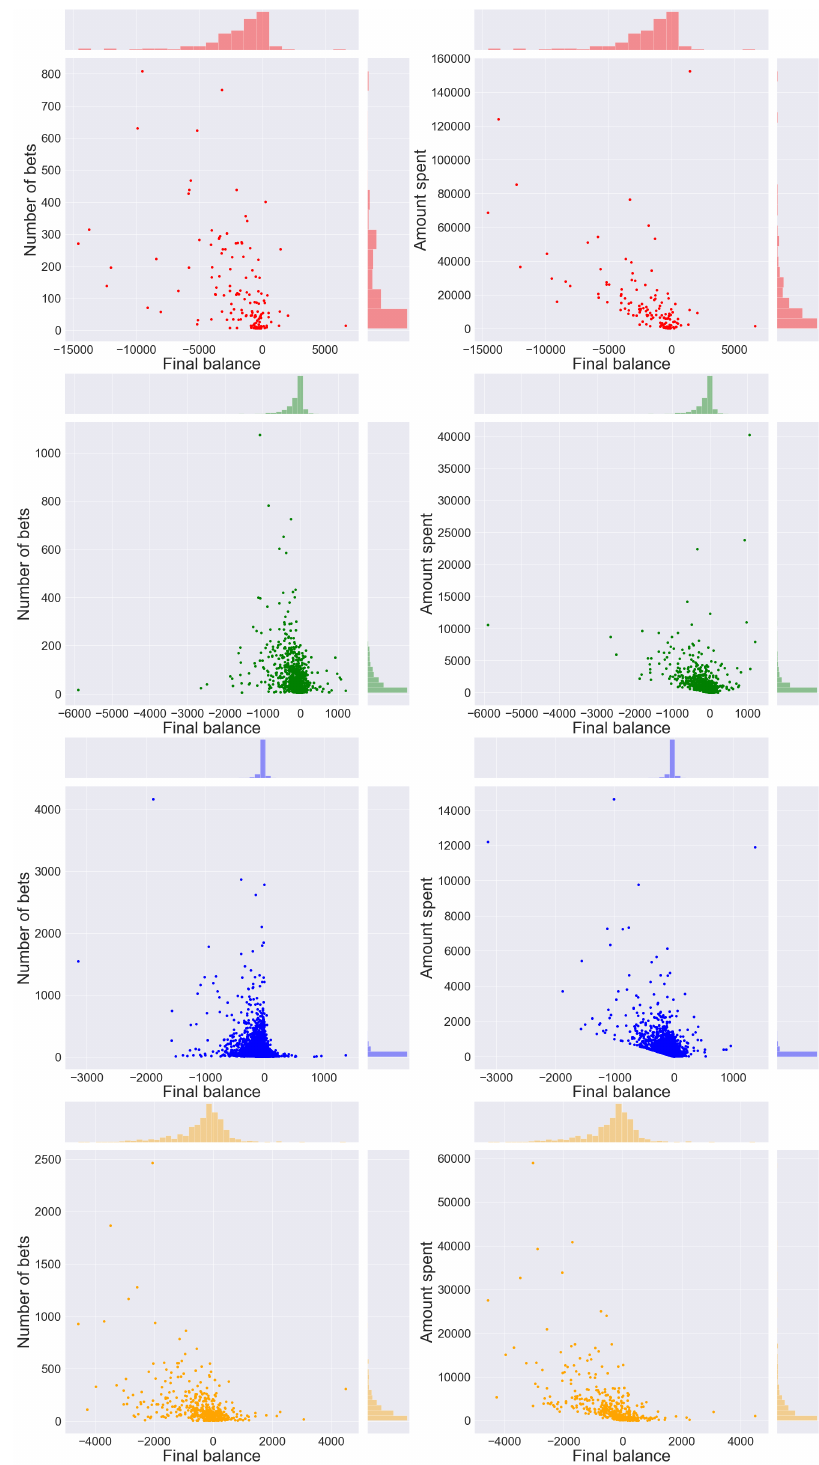
Figure 6. Bivariate scatter plots obtained using the time series k -means algorithm. Each row of this figure highlights for a single cluster the relationships between the final balance-number of bets and the final balance-amount